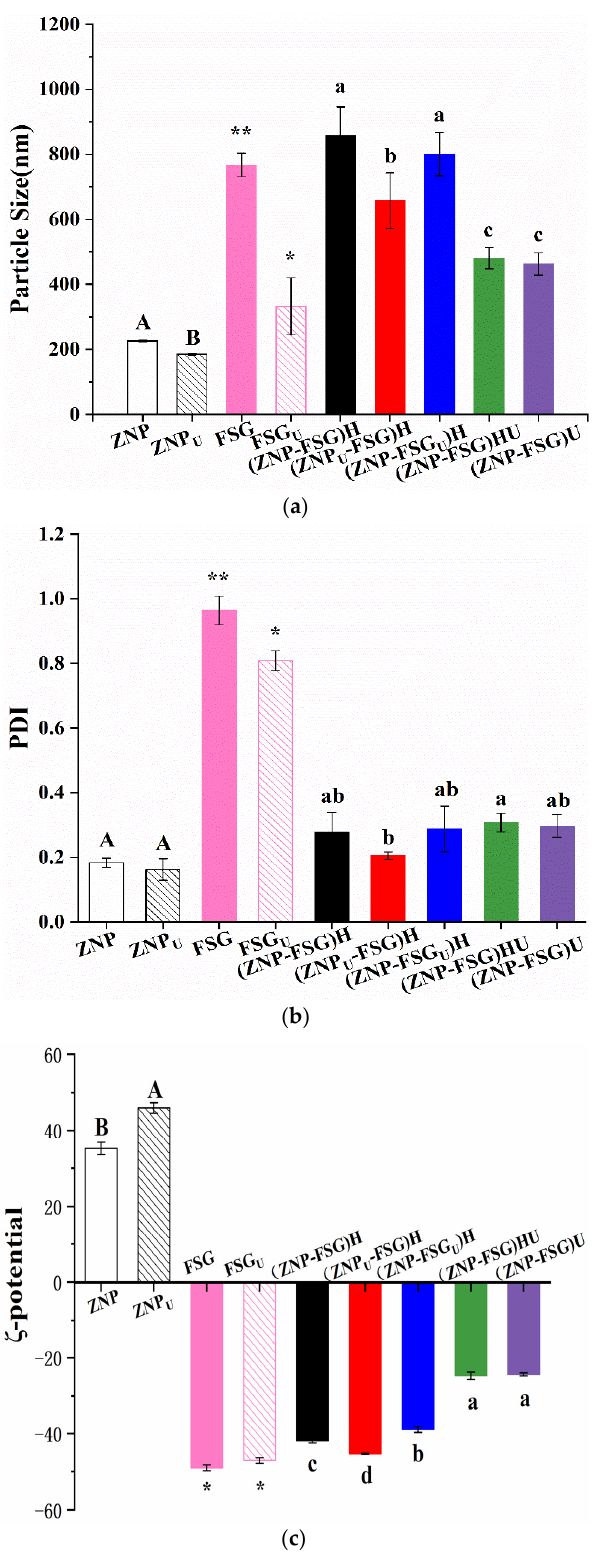
Figure 6. Particle size ( a ), PDI ( b ), and ζ -potential ( c ) of ZNP-FSG complexes subjected to various ultrasound and homogenization treatments. Different lowercase letters (a, b), different capital letters (A, B) and asterisk (*, **) indicated significant difference ( p < 0.05).